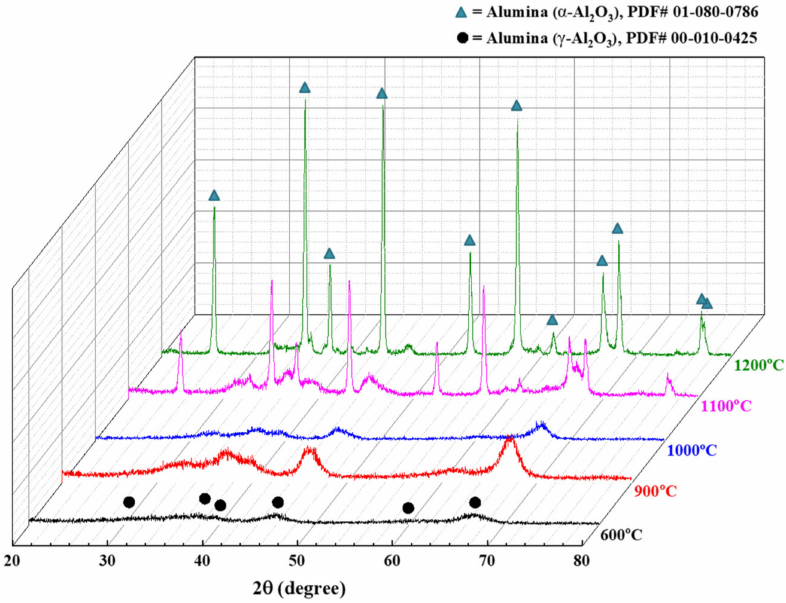
Figure 4. Effect of thermal treatment on the phase transformation of Al 2 O 3 membranes (pH = 3.5 and t = 24